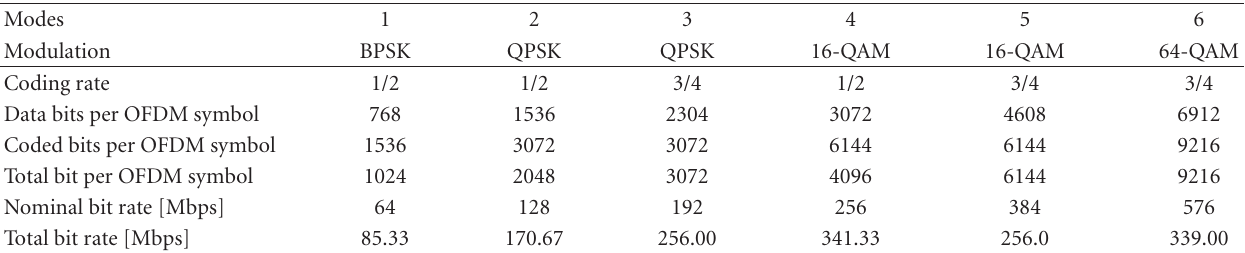
Table 2: Modulation and coding schemes (MCS) for the MIMO-OFDMA system.